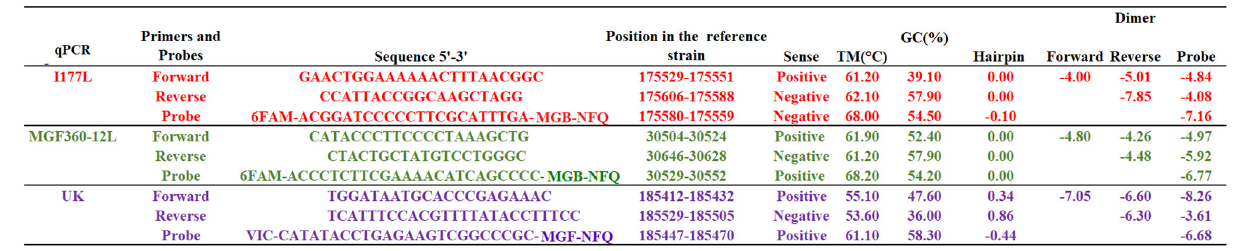
FIGURE 1 | Sequences of primers and probes used in the qPCR reactions as well as multiple parameters calculated during these developments. Hairpin and dimer values are expressed in standard Gibbs free energy ( 1 G kcal/mole). Designs were carried out using the RealTime qPCR Assay tool. Probes were labeled at 5 ′ with FAM (Fluorescein amidites) or VIC (Victoria) dyes and at 3 ′ with MGB-NFQ (Minor groove binder-non fluorescent